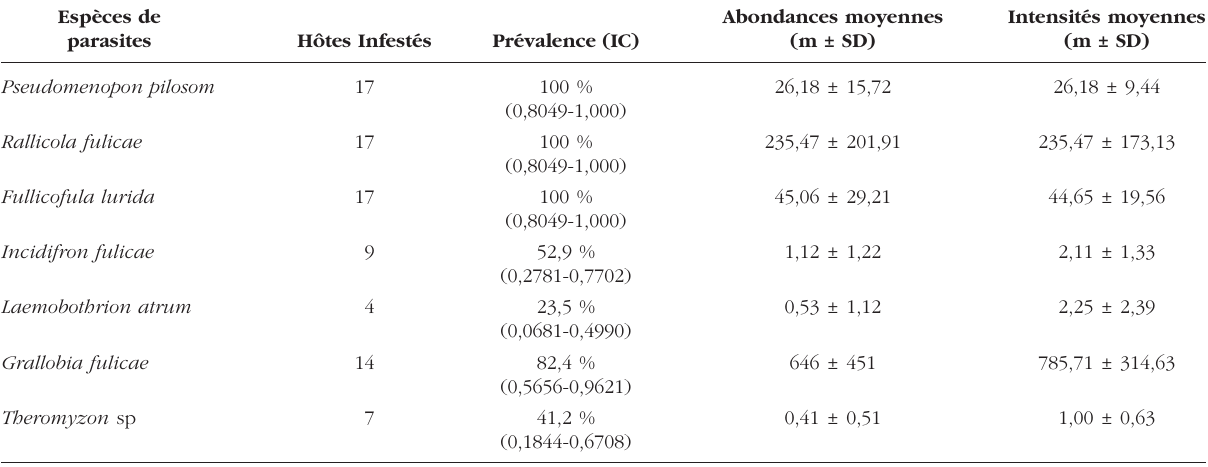
Tableau II. – Prévalence, abondance et intensité des espèces parasites de Fulica